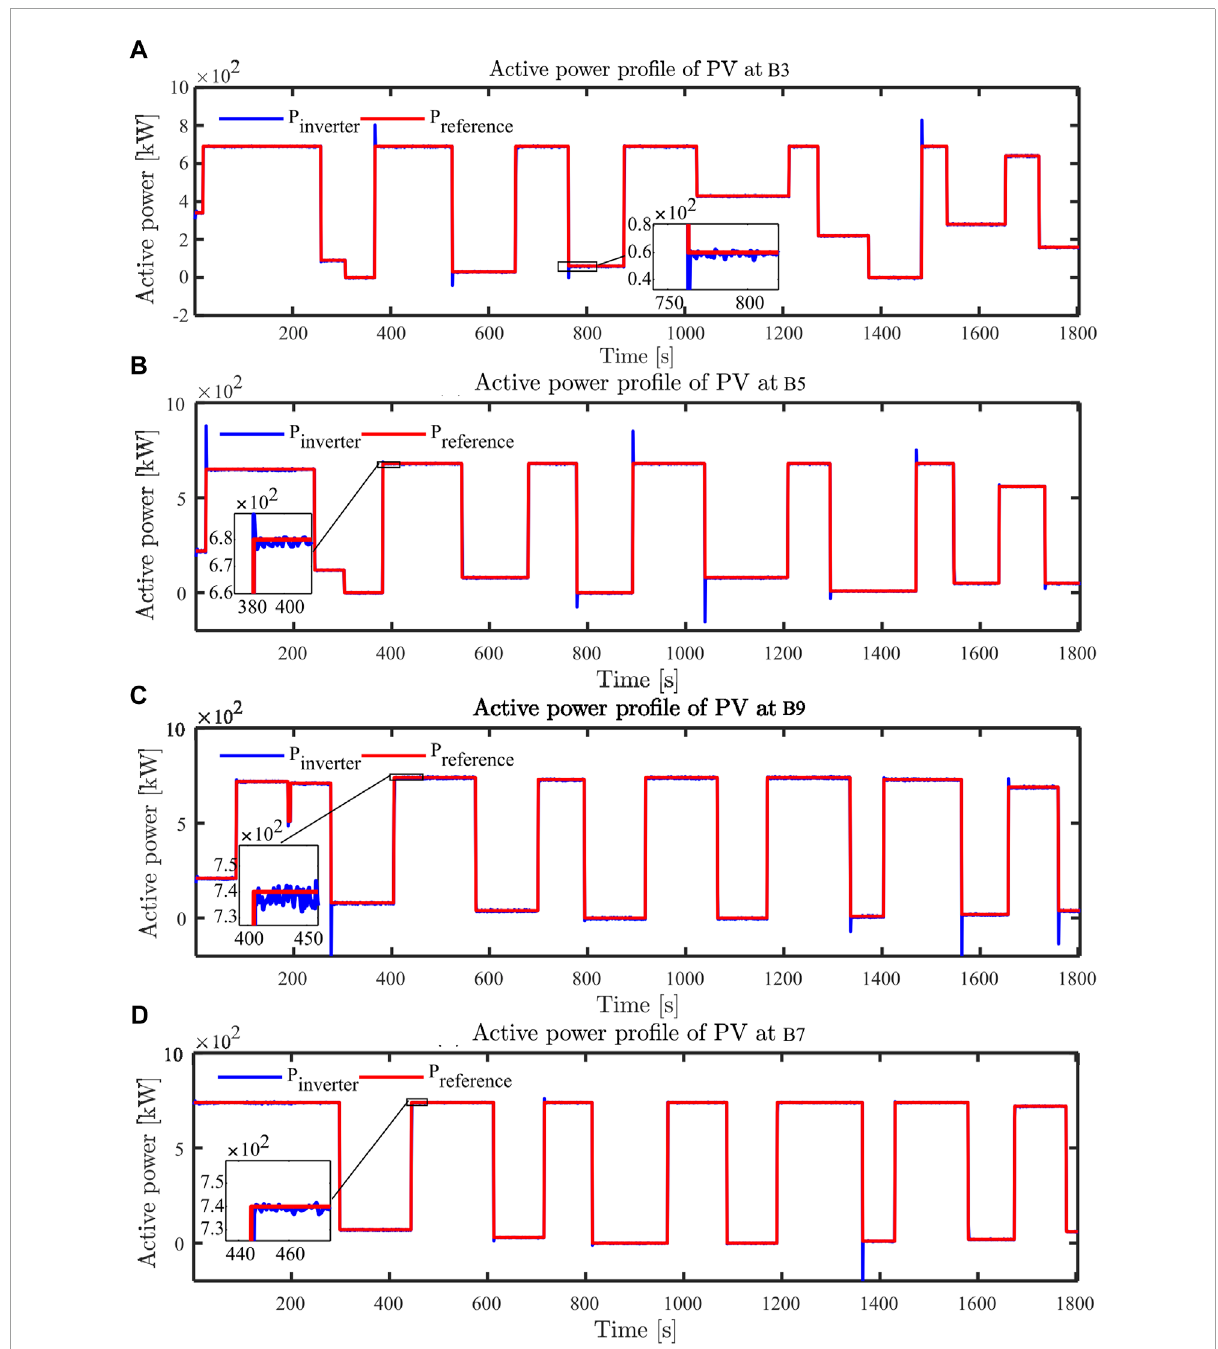
FIGURE 6 Active power profile of PV at (A) B3, (B) B5, (C) B9, and (D) B7.